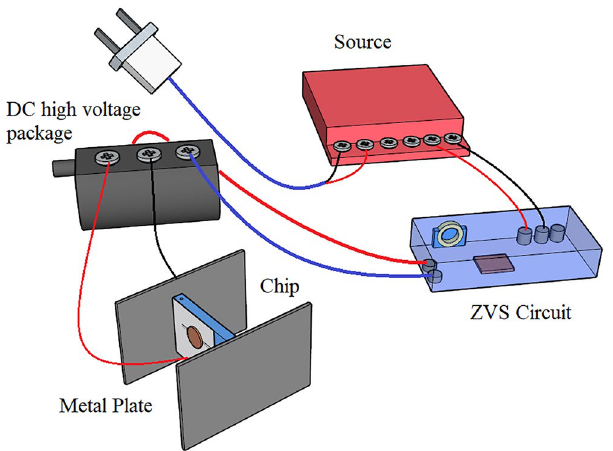
Figure 2. Schematic diagram of applied high-voltage electric field experimental